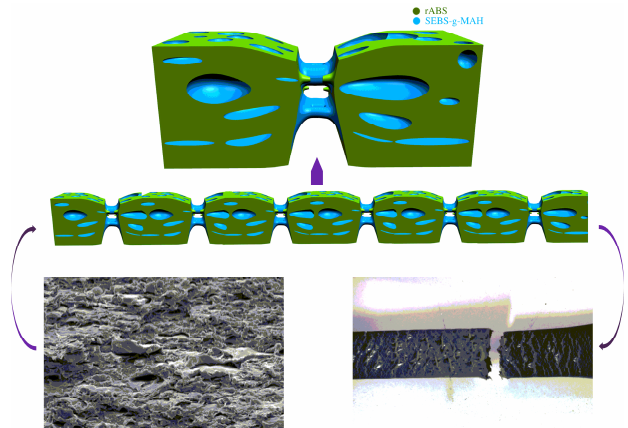
Figure 7. Fracture model of the tensile specimen of the rABS/SEBS-g-MAH (80/20) blend.